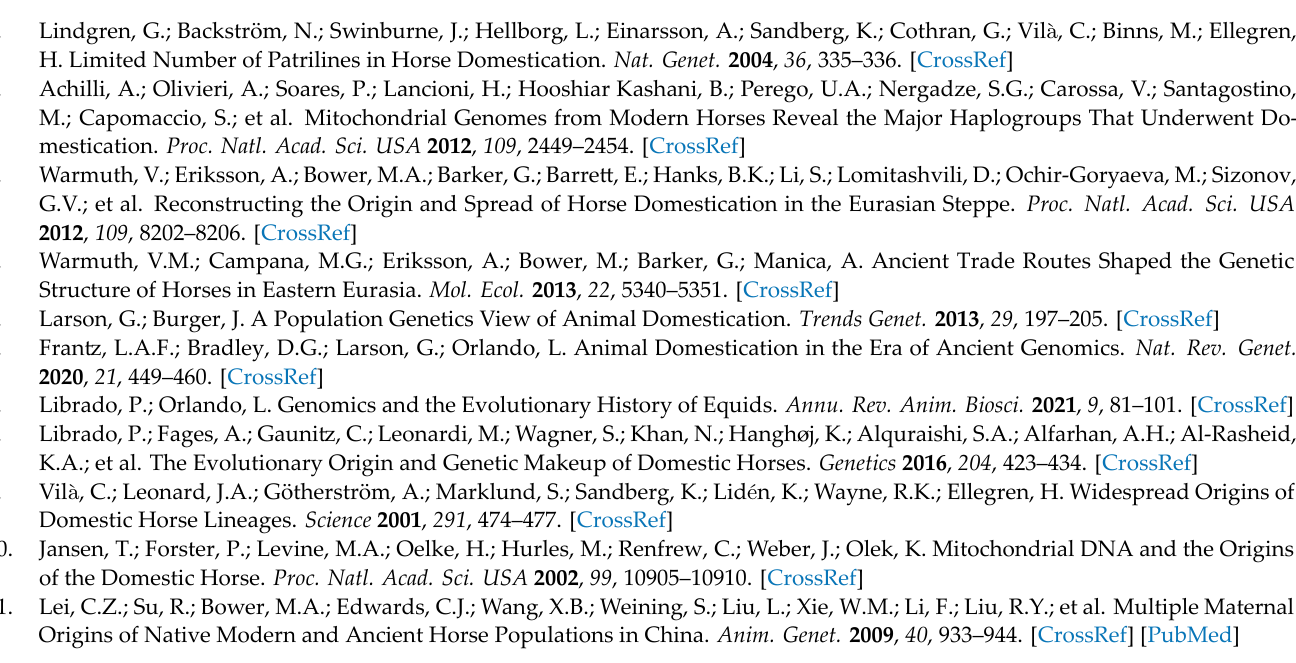
Table S3: Summary of horses from 76 modern breeds classified in Y‑chromosome haplotypes (HT and CHT) as reported in [144,146], respectively; Table S4: Geographic origin and haplogroup clas‑ sification for the 429 samples phylogenetically analysed in [81,91,92,111]; Table S5: Haplogroup frequencies and “crown” and “non‑crown” proportions for the 46 modern horse breeds analysed in